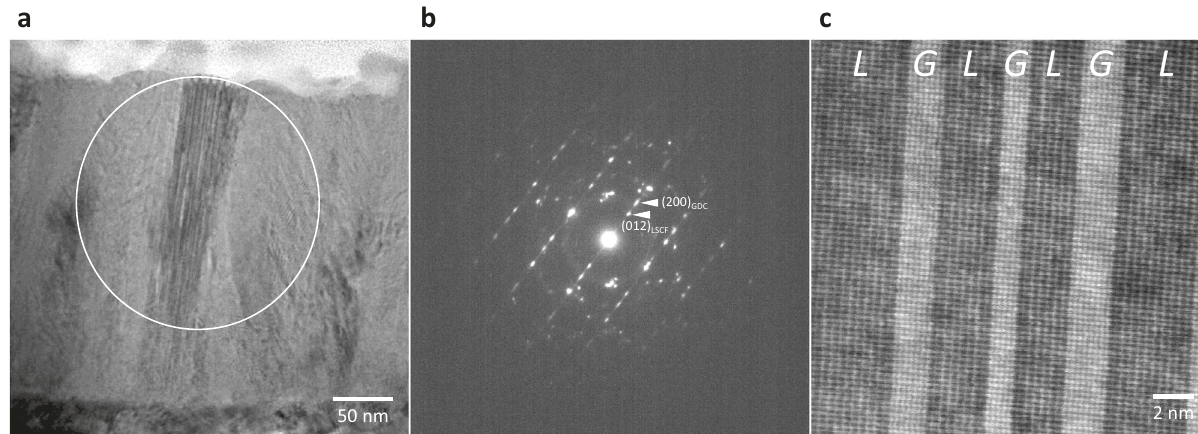
Fig. 2 Phase identi fi cation of the LSCF-GDC nanocomposite fi lm. a Low-magni fi cation cross-sectional TEM image depicting granular domains containing nanostripes. b Selected area electron diffraction (SAED) pattern of the region denoted by a circle in a . c STEM-HAADF lattice image of the LSCF-GDC nanocomposite fi lm, showing the coherent, quasi-epitaxial interfaces between the LSCF and GDC phases, denoted as L and G on the image, respectively.